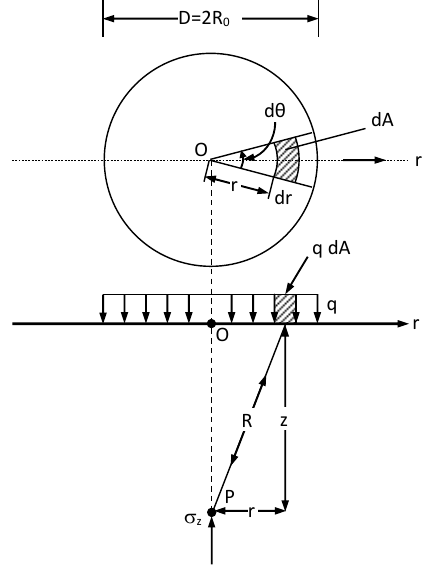
Figure 1. Vertical stress under a uniformly loaded circular area.